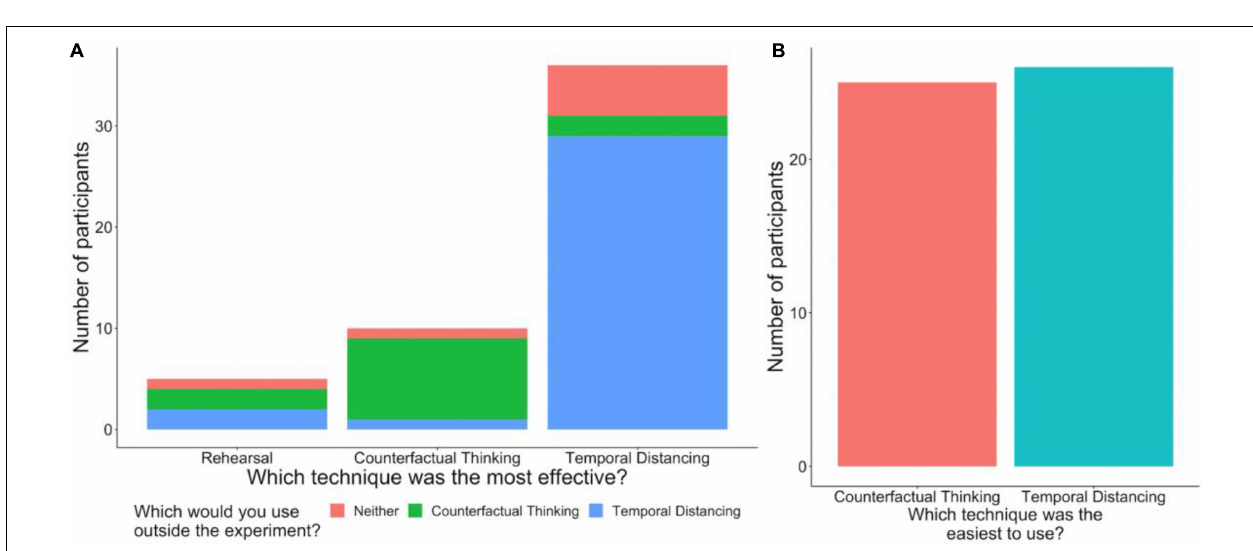
FIGURE 3 | Corrugator EMG amplitude during emotion regulation. Average corrugator response per condition during memory-reactivated emotion regulation (Session 2). Corrugator reactivity was higher during counterfactual thinking than during rehearsal or temporal distancing. Error bars represent standard error of the mean, ∗∗∗ p < = 0.001.